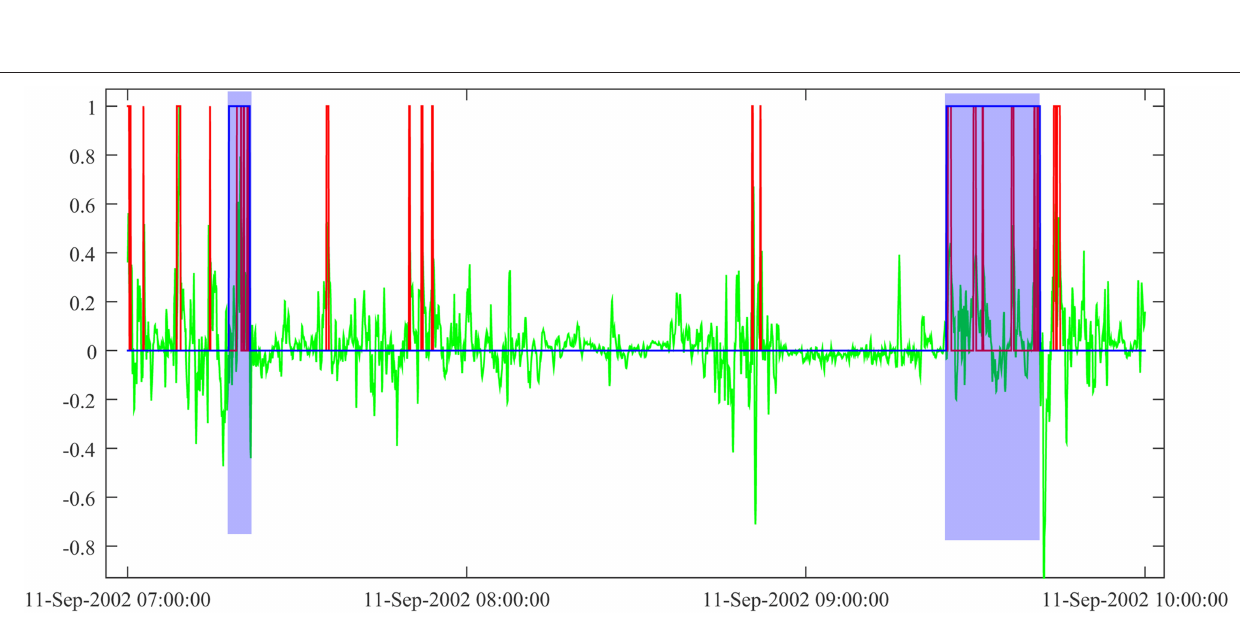
Frontiers in Astronomy and Space Sciences | www.frontiersin.org